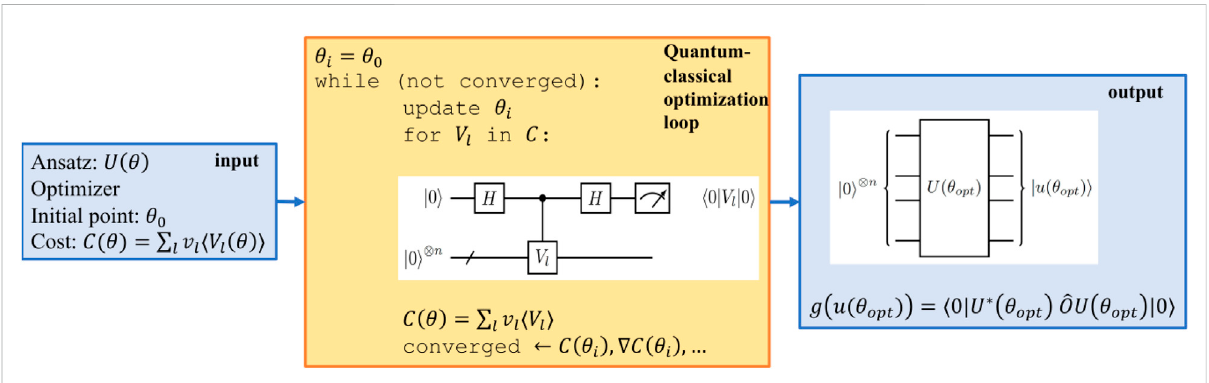
FIGURE 3 Workingprincipleofvariationalquantumalgorithms.Theinputarethehyperparameters,suchasansatz,optimizerandtypeofcostfunctionand theinitialvalueoftheansatzparameter.Thecostisshownhereasalinearcombinationofexpectationvaluesofunitaries,althoughotherexpressions are possible. In the quantum-classical optimization loop, the classical computer is in charge of updating the parameters θ according to the optimization logic, while the quantum computer evaluates the cost function terms. At the end of the optimization, the optimal parameter set θ (| u ( θ ) 〉 (cid:2) U ( θ )| 0 〉 ⊗ n ) orinalargercircuittoobtainascalarfunctionofthe opt canbeusedtoreconstructtheapproximatesolutionasawavefunction solution g ( u